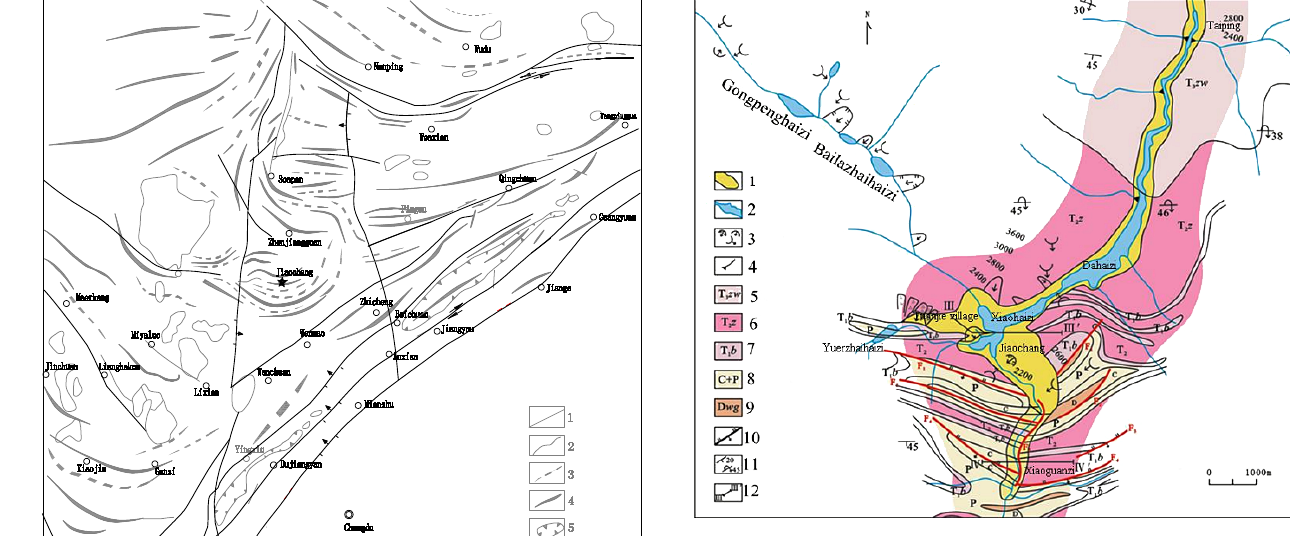
Figure 2. Geological map of the Diexi